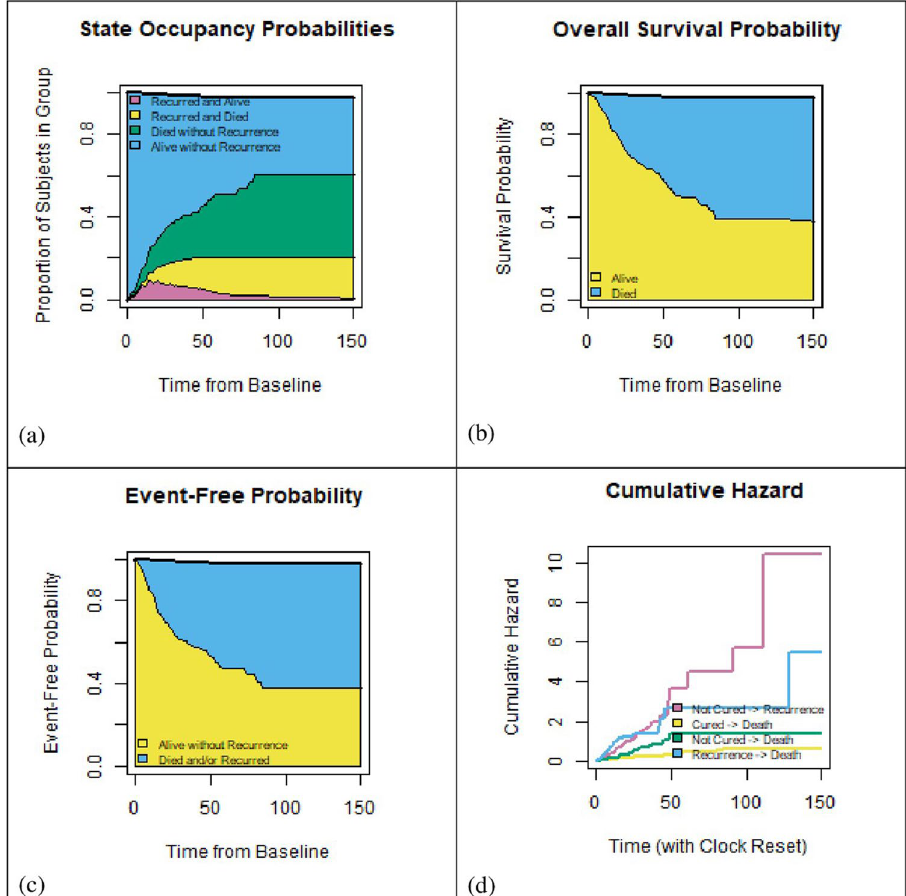
Figure 3. State occupancy probabilities, overall survival, event-free survival, and cumulative hazards for all transitions according to Multi-state cure model for a hypothetical subject with mean values of all